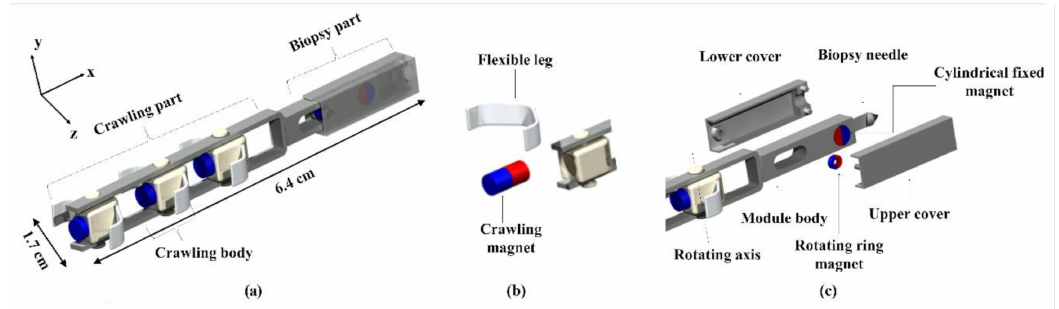
Figure 1. ( a ) Proposed CMR composed of a crawling part and a biopsy part. ( b ) Structure of crawling body. ( c ) Structure of biopsy